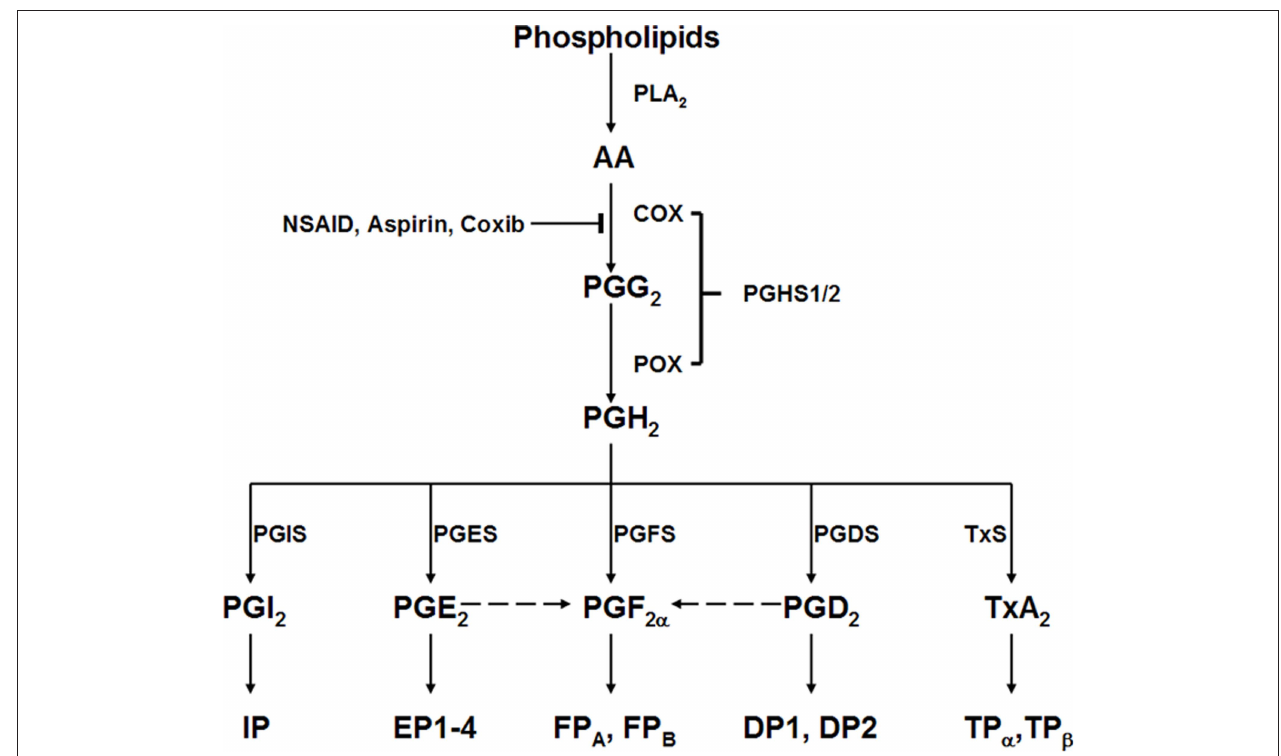
Figure 1 | Prostanoid biosynthesis and response pathway. AA, arachidonic acid; PLA , phospholipase A ; PGHS1/2, prostaglandin G/H synthase 1 or 2, 2 2 which contains both cyclooxygenases (COX) and peroxidase (POX) activities; PGIS, prostaglandin I synthase; PGES, prostaglandin E 2